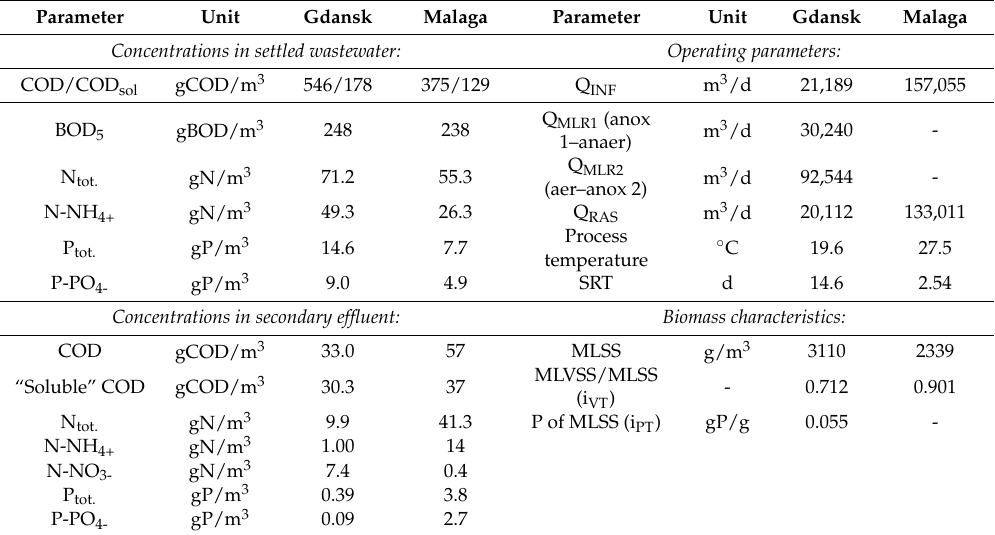
Table 1. Characteristics of the average operating conditions during the study